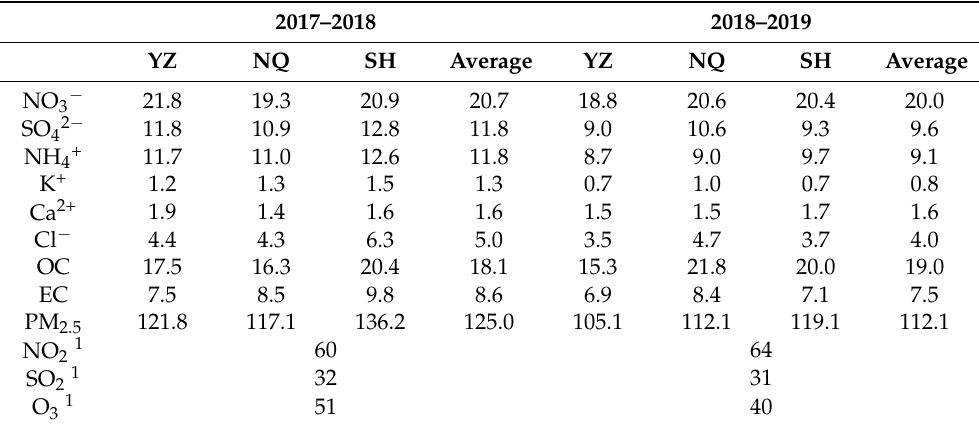
Table 1. Mean concentrations and major chemical components of PM 2.5 , and the concentrations of the gaseous pollutants of autumn–winter seasons at Xingtai ( μ g/m 3 ).